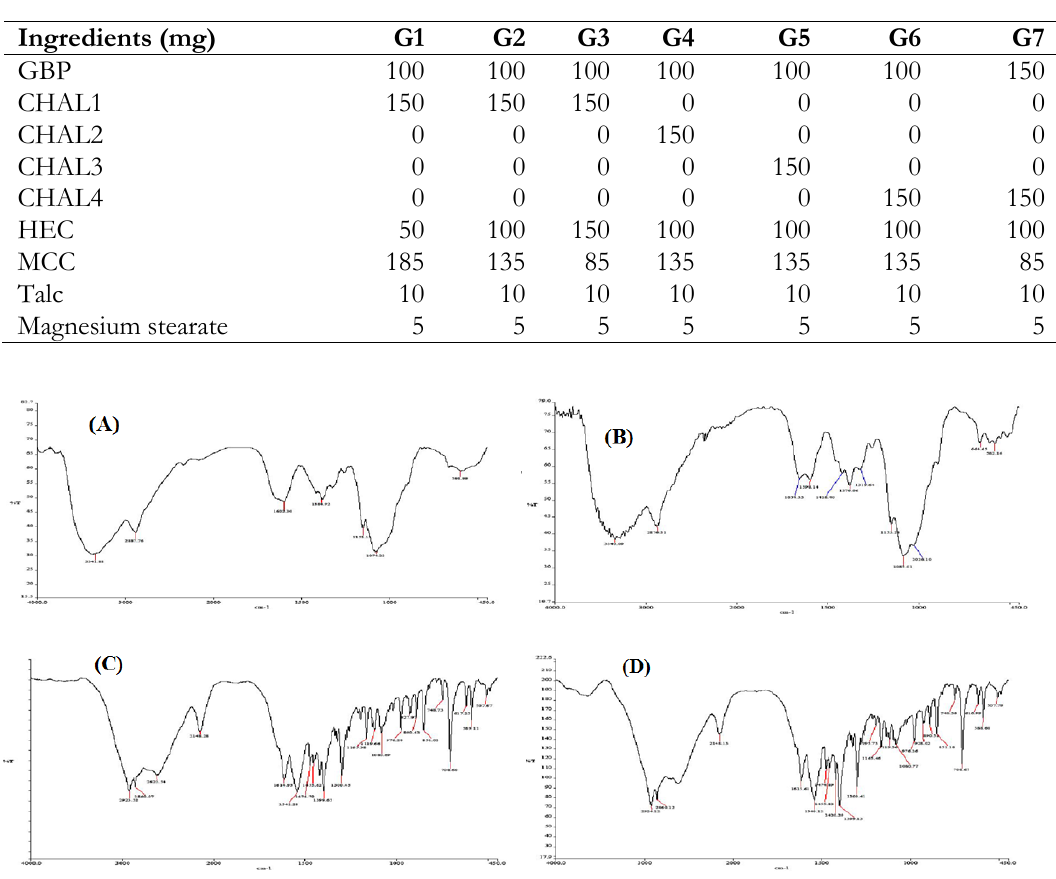
Figure 1. FTIR spectra of CH (A) and CHAL3 (B), FTIR spectra of GBP (C) and physical mixture of GBP and other excipients